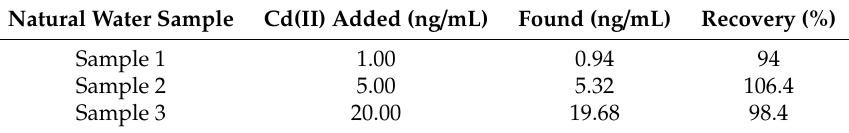
Table 2. Determination of Cd(II) in natural water samples Natural Water